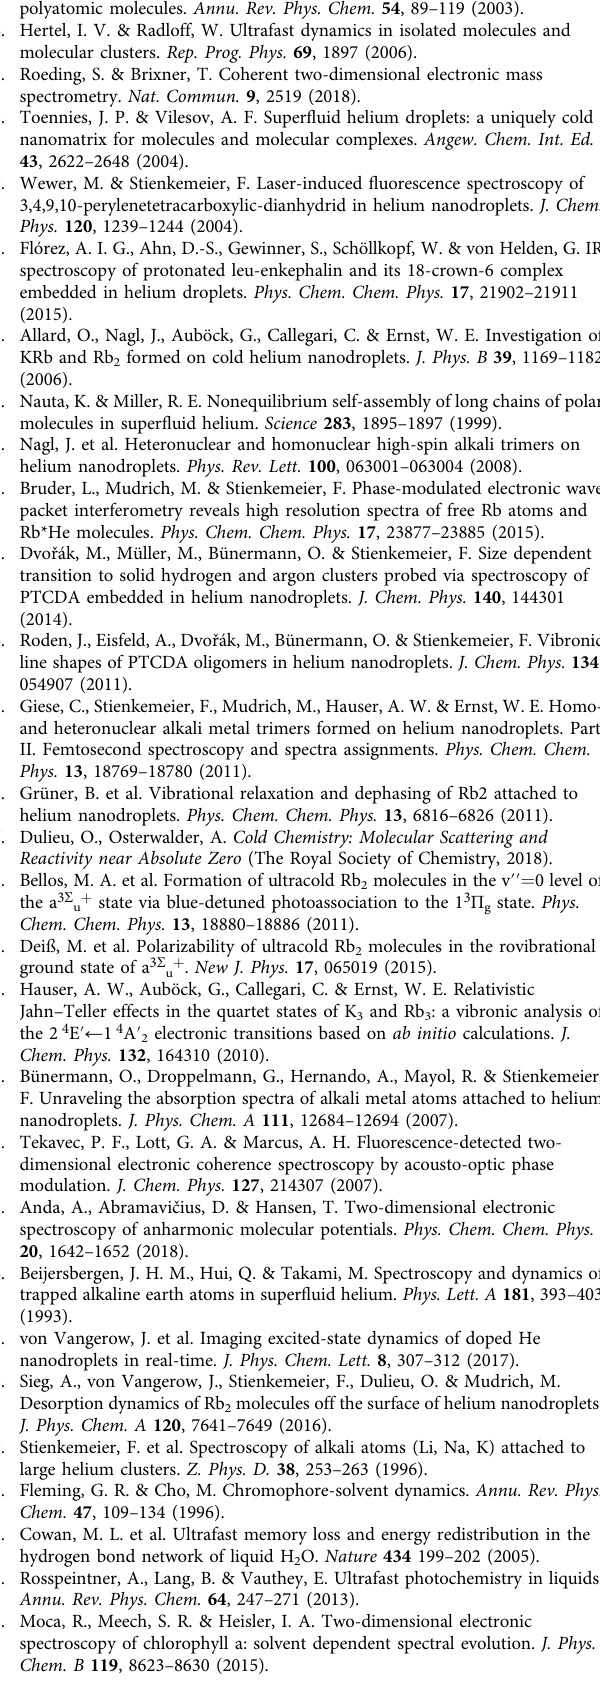
Methods Sample preparation . Helium nanodroplet beam generation is described in detail elsewhere 45 . An extended sketch of our vacuum apparatus is shown in Supple- mentary Fig. 1 along with the formation mechanism of Rb molecules. 4 He gas (purity grade 6.0) is continuously expanded through a nozzle (5 µm diameter) cooled to 17K with a stagnation pressure of 50 bar, leading to a mean droplet size of 7000 helium atoms. Upon condensation and evaporation, the droplets cool down to 370 mK 16 and undergo a phase transition into the super fl uid phase. The droplet beam passes through a temperature-controlled pick-up cell (1 cm length, T = 377K) containing a low-density Rb vapor (3.9 ×10 − 4 mbar). Alkali-metal atoms do not immerse into the droplets 31 . Pick-up of multiple atoms thus leads to molecule/cluster formation on the droplet surface. Thereby, the released binding energy is effectively dissipated upon evaporation of helium atoms, assisting the formation of the weakly-bound lowest high-spin electronic states of Rb 2 and Rb 3 molecules accompanied with cooling to their vibrational ground level. The con- siderably larger energy release of the low-spin electronic ground states of Rb molecules leads to an enhanced evaporation or droplet destruction, causing a predominance of the high-spin Rb molecules in the experiment 46 . Optical setup and data acquisition . The 2DES optical setup is based on the phase modulation (PM) technique developed by Marcus and coworkers 32 . Details are found in the Supplementary Note 1, along with a detailed layout of the optical setup in Supplementary Fig. 2. Brie fl y, four phase-modulated collinear pulses are focused ( f = 300mm) into the interaction region of the detector to induce the nonlinear signals (Fig. 1b). Ionization is either performed with a separate fi fth pulse (delayed by Δ = 2 ns) or by absorbing additional photons from pulse 4. Inde- pendent wavelength tuning of pulse 5 allows for selective ampli fi cation/dis- crimination of speci fi c spectral features. Photoelectrons or mass-resolved photoions are detected with a channeltron detector. For each evolution time T , the coherence times τ and t are scanned and Fourier transformed afterwards to yield 2D frequency-correlation spectra of which the real part is shown. To isolate the weak nonlinear signal components, the phase ϕ i of each pulse is individually modulated (Fig. 1b) at radio frequencies Ω i , leading to characteristic modulation signatures for the rephasing ( Ω RP ¼ Ω 43 (cid:2) Ω 21 ¼ 3 kHz) and non-rephasing ( Ω NRP ¼ Ω 43 þ Ω 21 ¼ 13 kHz) third-order signals, which are separated upon lock- in detection. Thereby, amplitude and phase information are retrieved through heterodyned detection by referencing the lock-in ampli fi er to a suitable reference. The excitation scheme along with double-sided Feynman diagrams and phase signatures of pathway contributions is shown in Supplementary Fig.